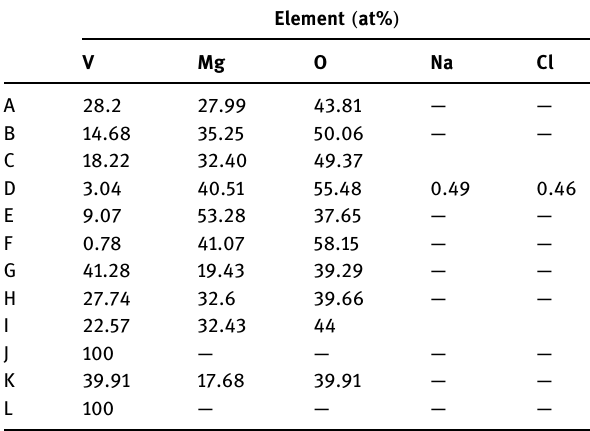
Table 4: EDS analysis results of di ff erent regions of the product